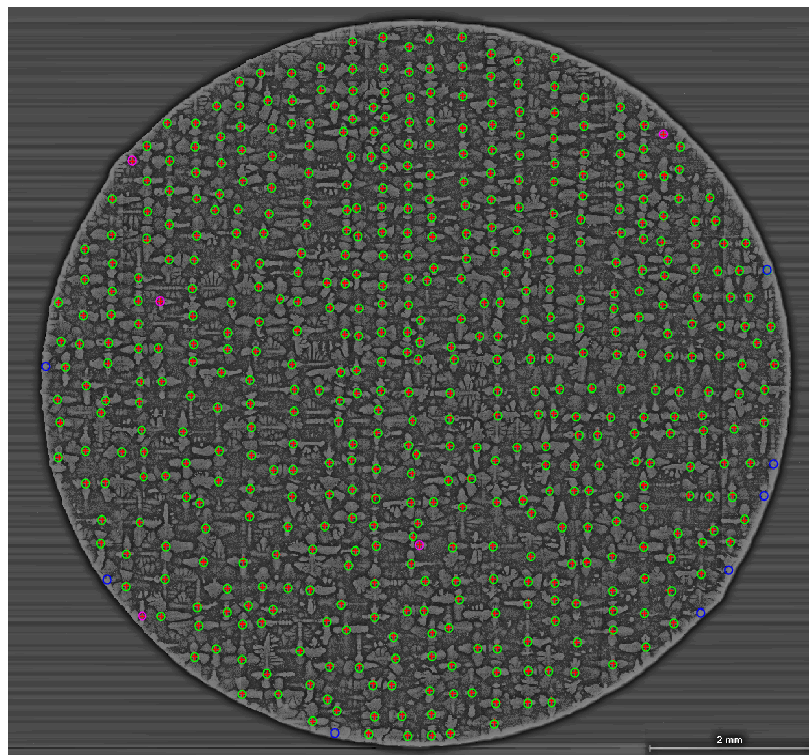
Figure 10. Final processed and mapped image. Dendrite cores are identified with red crosses. Green circles refer to manually selected cores, blue missed out cores, and purple circles detected cores that were omitted from the manual selection. The dendrites highlighted by the purple circles are false positives that have similar shape and intensity to a dendrite core but smaller size and are tertiary or secondary arms in nature.